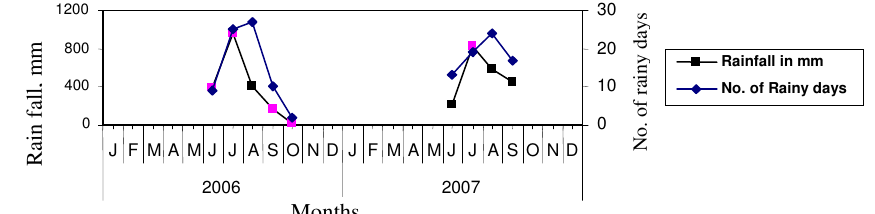
Figure 2. Rain fall (in mm) and number of rainy days at an urban atmosphere.